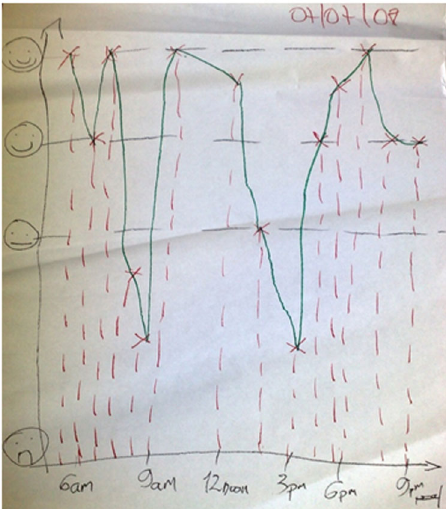
Fig. 4 Previous day. Flipchart recording one participant ’ s evaluation of her happiness over the course of the previous day. From left to right on the horizontal axis: hours of the day in a typical day. From bottom to top on the vertical axis, smiley faces mark levels of happiness from unhappy to